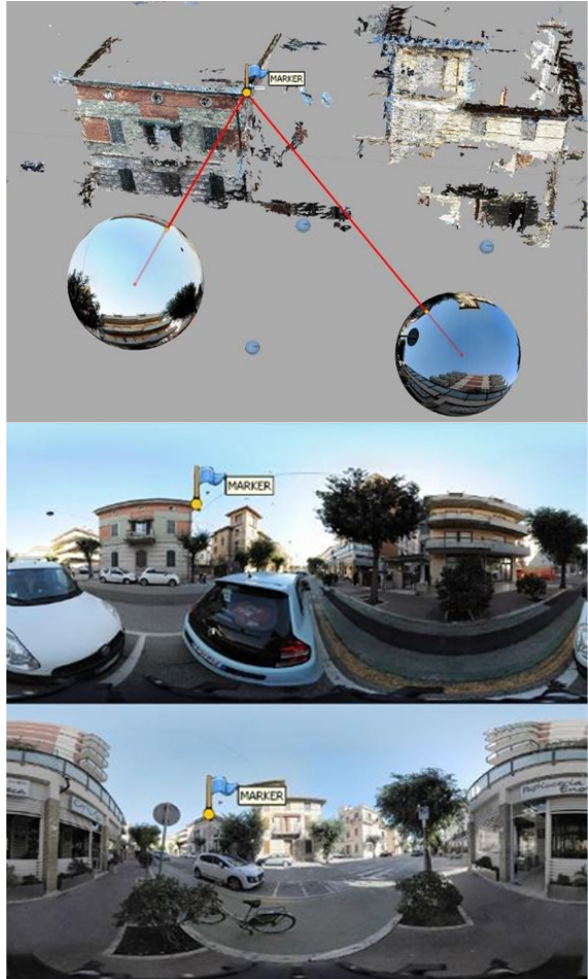
Figure 2: Projection of a marker point from the point of view of a couple of spherical images (top), and the identification of the same marker point on the equirectangular images